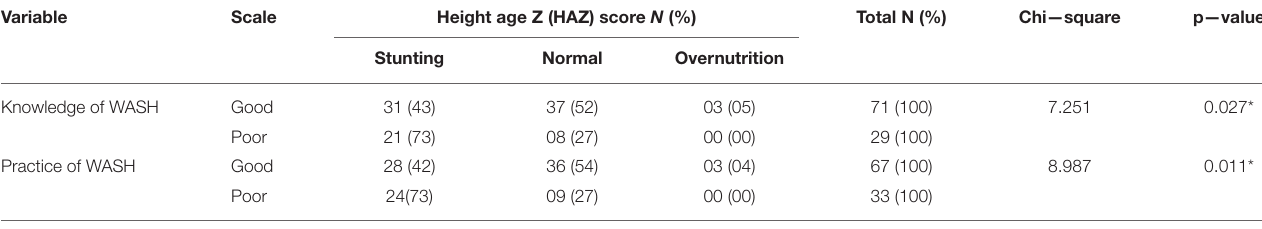
TABLE 3 | Association of mother’s WASH knowledge and practice and nutritional status of children. Variable Chi—square